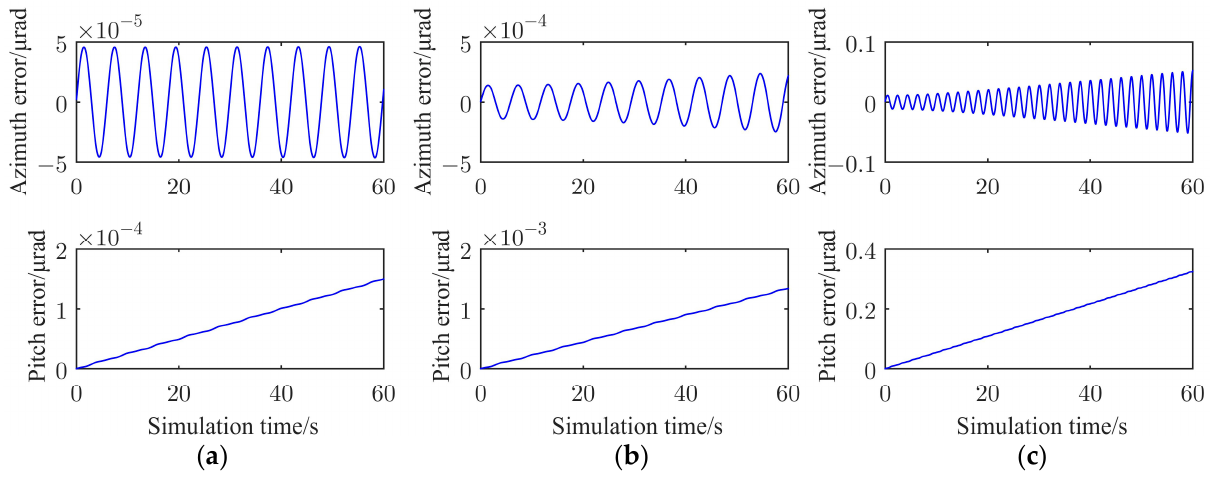
Figure 14. The error curve of the calculation of the indirect numerical calculation method in the reflector coordinate system O 44 X 44 Y 44 Z 44 . ( a ) a = 1 ◦ , ω = 60 ◦ /s; ( b ) a = 3 ◦ , ω = 60 ◦ /s; ( c ) a = 1 ◦ , ω = 180 ◦ /s.